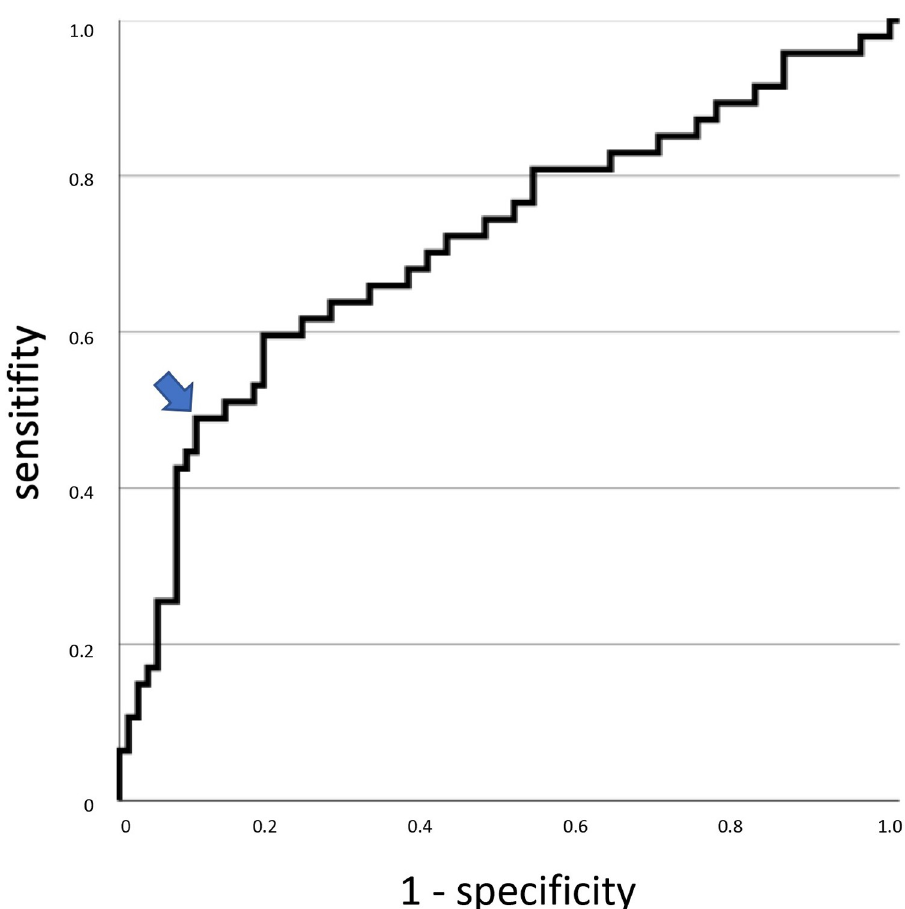
Fig 1. The receiver operating characteristics curve for linear regression model only including the parameters age and initial platelet count. The blue arrow marks the point that corresponds to a sensitivity at 44.7 and a specificity at 91.4. Using this point as a separator to divide the patient population into two groups, mortality in the first group is 26% (including 78% of the patients) and 75% in the second group (including 22% of the patients).